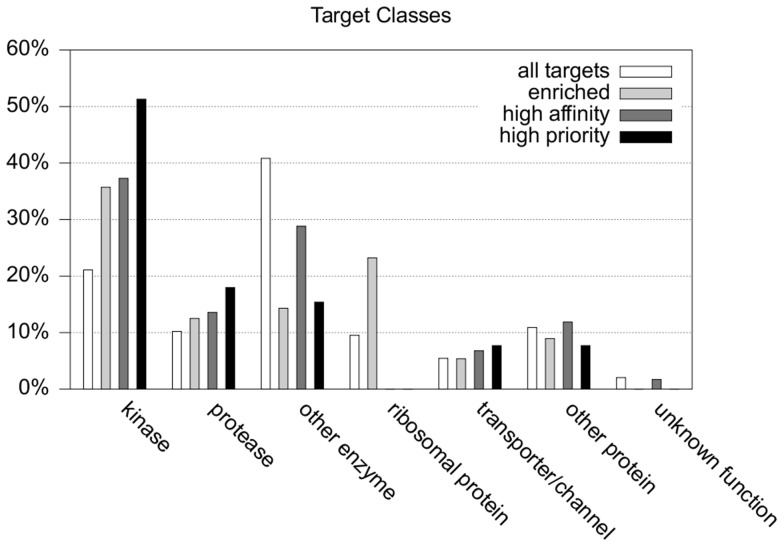
Protein classes of predicted targets.White bars represent the predicted relevant target space, whereas the different prioritized subsets are depicted by shaded bars.